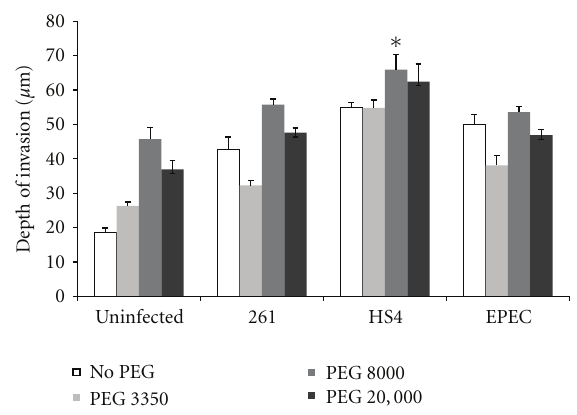
Figure 4: Quantitative analysis of depth of invasion. Depth of invasion was analyzed as described in Methods. All three PEGs and all three bacterial strains independently increased depth of invasion. A decrease in invasion was noted when samples were treated with PEG 3350 and either 261 or EPEC. Treatment with any bacterial strain and either PEG 8000 or PEG 20,000 led to increased invasion. The greatest increase was seen when samples were treated with PEG 8000 and HS4. Standard Student’s t -test was applied to the samples and the P < 0 . 05 were obtained for samples treated with PEG 8000 and HS4 indicated by an asterisk ( ∗ ).